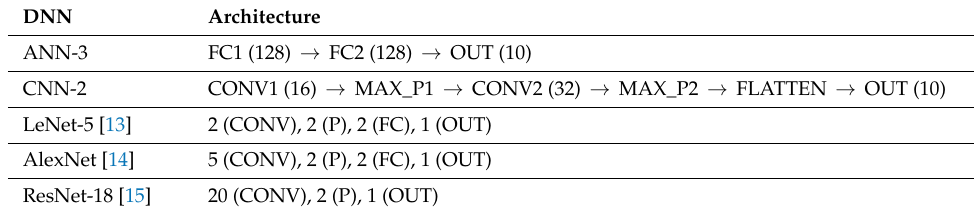
Table 1. The number of neurons within the fully connected (FC) layers, output (OUT) layer, pooling (P) layers, and the convolutional (CONV) layers are shown for the ANN-3 and CNN-2 architec- tures. For CNN-2, MAX_P1, and MAX_P2, refer to the first and second max-pooling layers, re- spectively. The number of CONV, P, FC, and OUT layers are provided for LeNet-5, AlexNet, and ResNet-18